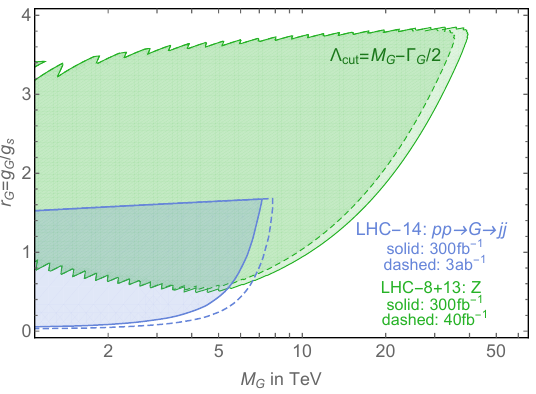
Figure 10 . Comparison of future reach of conventional bump-hunt searches and the EFT limit, for the color octet vector G . The blue shaded region, from [109], shows the projected limits of 14 TeV LHC on pp ! G ! jj while the green shaded region corresponds to the EFT reach obtained by combining 8 TeV and 13 TeV datasets. The limits are obtained by using the 95% CL bound in (cid:12)gure 8 with (cid:3) cut = M (cid:0) (cid:0) G =